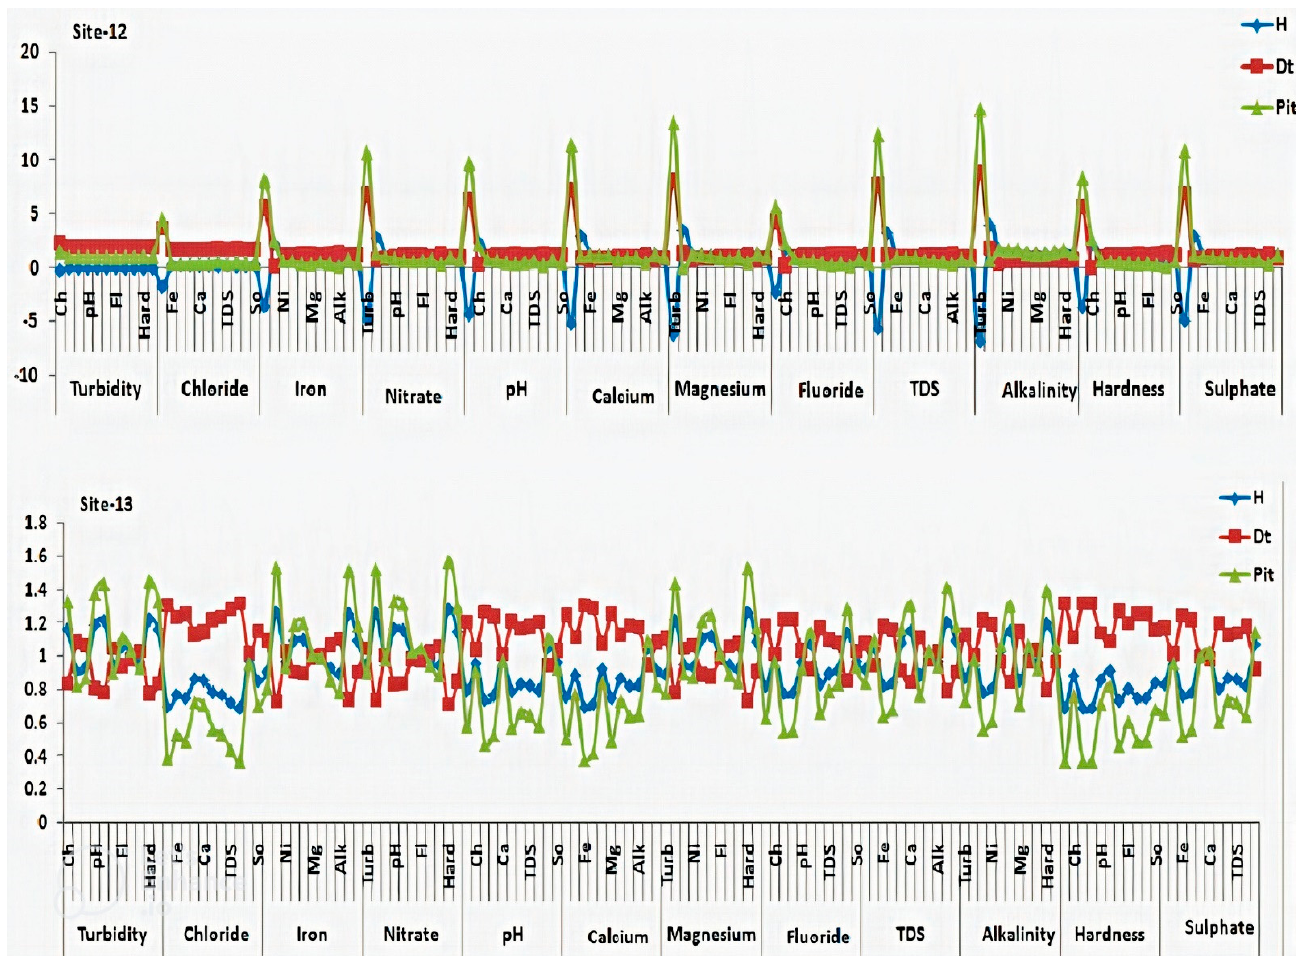
Figure 6. Variation in the Hurts exponent (H), fractal dimension (D) and predictability (PI) of the water quality parameters in the 13 different locations of the State Uttarakhand.